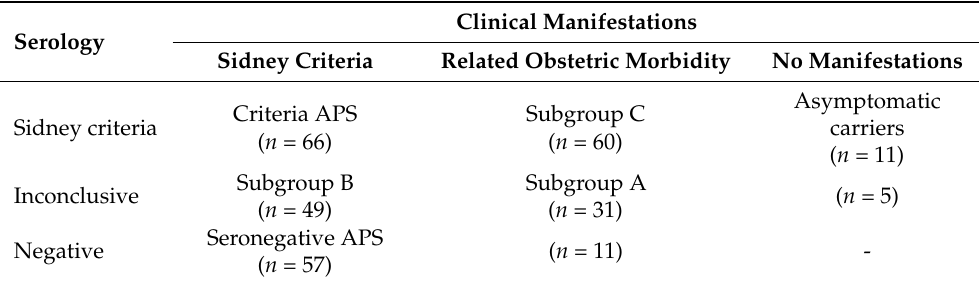
Table 2. Study groups according to the clinical and serological manifestations of the Sydney criteria and the presence of obstetric morbidity related to antiphospholipid syndrome (APS) *. Clinical Manifestations Serology Sidney Criteria Related Obstetric Morbidity No Manifestations Asymptomatic Criteria APS Subgroup C Sidney criteria carriers ( n = 66) ( n = 60) ( n = 11) Subgroup B Subgroup A Inconclusive